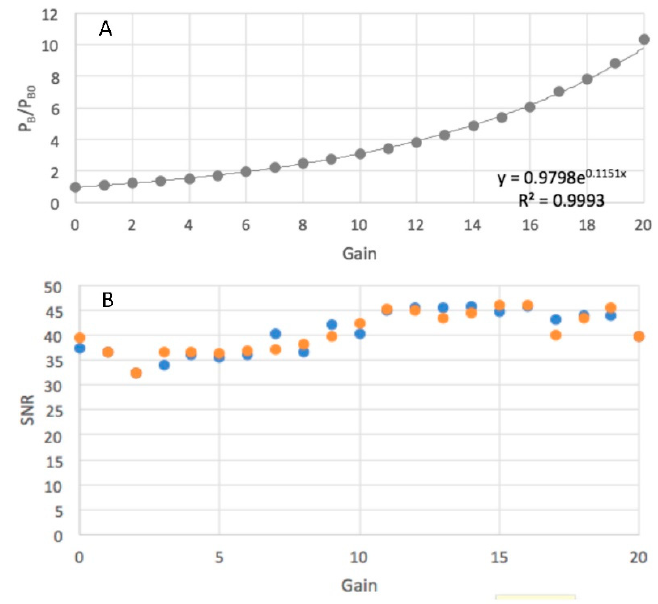
Figure 11. The dependence on the gain parameter of ( A) , the pixel level and ( B) , the signal-to-noise ratio with 16-bit images in blue and 8-bit images in orange.